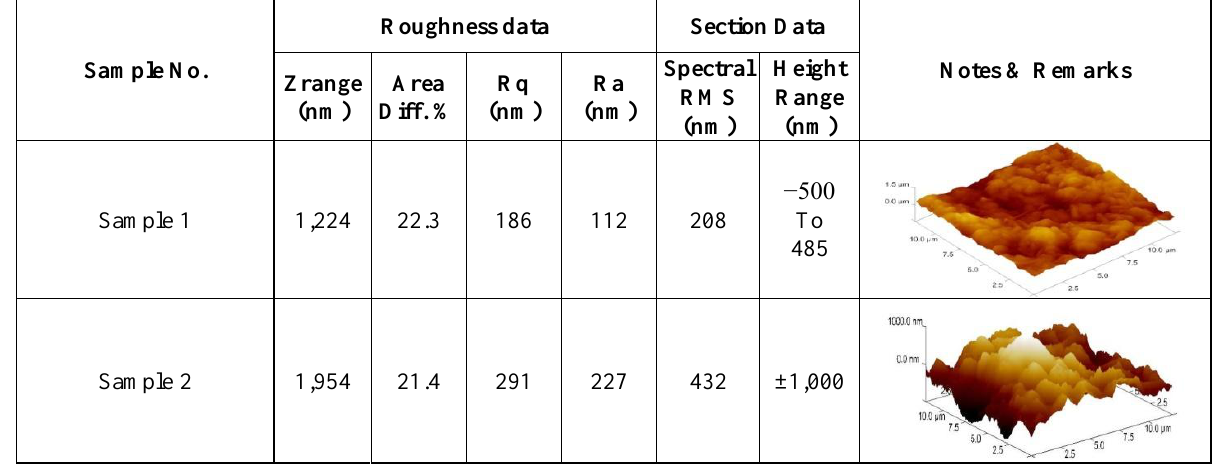
Table 3. Recommended surface controlling parameters for GC415 multilayer coated carbide.